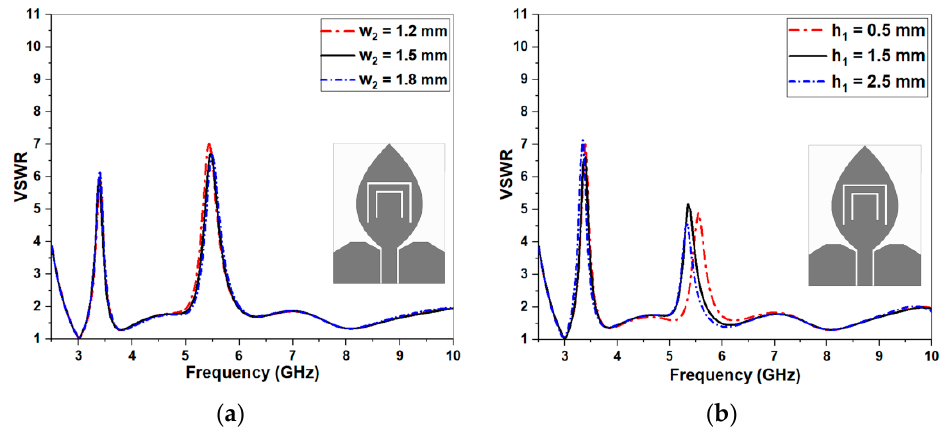
Figure 5. Effect of the interval between two loaded slots on VSWR: ( a ) horizontal; ( b ) vertical.